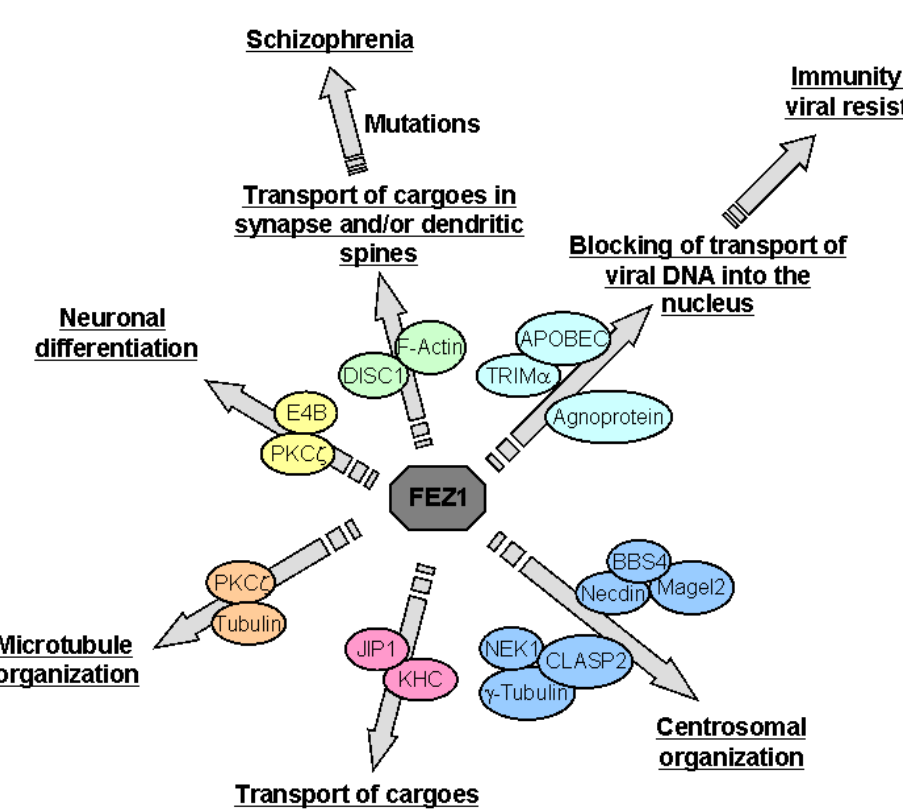
FIGURE 2. Functions of FEZ1 based on its binding partners. Details are described in the